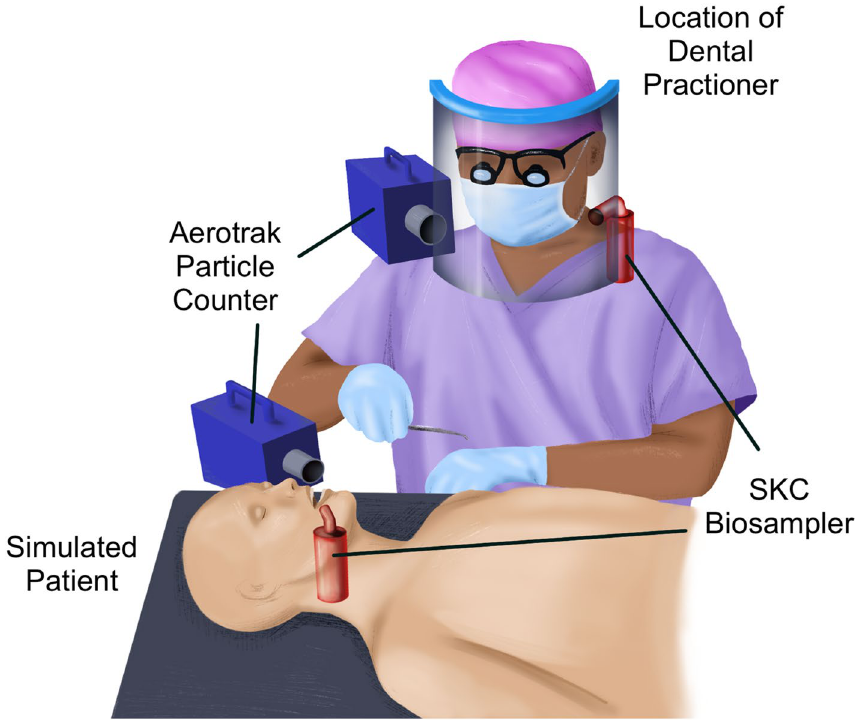
Figure 1. Experimental setup of orthodontic care with active MS2 in the oral cavity of the simulated patient. SKC Biosamplers and optical particle counters simultaneously sampled near the oral cavity of the patient and behind the face shield of the